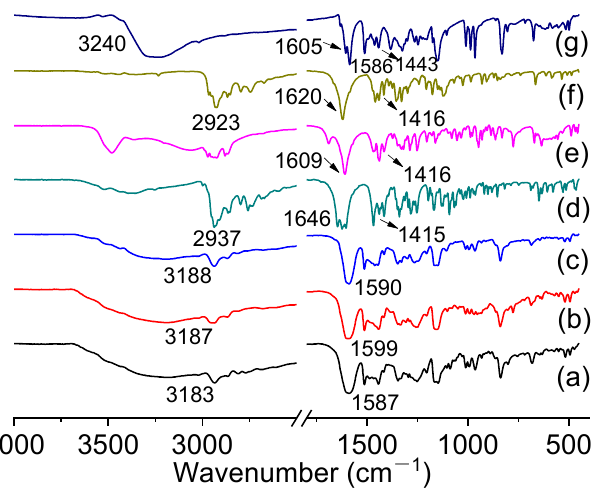
Figure 3. The FTIR spectra of co-amorphous forms of MAR-RES (a), OMAR-RES (b), and SPD-RES (c), as well as crystalline forms of matrine (d), oxymatrine (e), sophoridine (f), and resveratrol (g). However, in the FTIR spectra of all co-amorphous samples, their characteristic peaks became broad and blunt compared to those of their crystalline counterparts (Figure 3a–c).